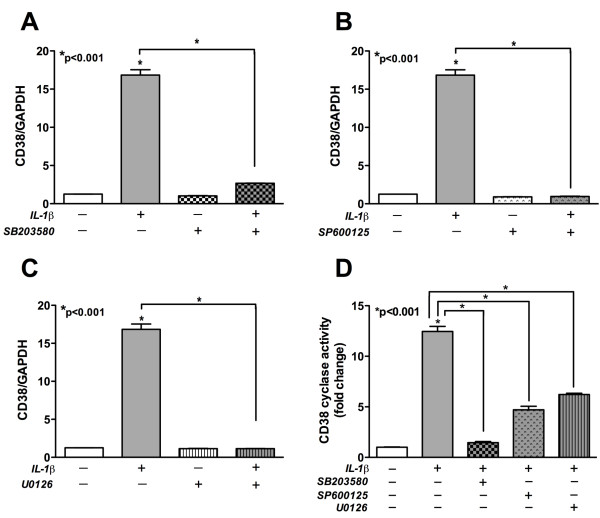
MAPKs regulated CD38 expression and function in IL-1β-activated astrocytes. Following 1 hour pre-treatment with various MAPK inhibitors, primary astrocytes were activated with IL-1β, 20 ng/ml. Untreated controls were maintained in parallel. CD38 mRNA levels were measured using real-time PCR while CD38 activity, as a measure of CD38 function, was analyzed using cADPR cyclase assay. As expected, IL-1β alone significantly increased CD38 expression and activity as compared to untreated controls (p < 0.001, all panels). Basal CD38 expression was unchanged (p > 0.05, A-C) by inhibitor pre-treatment. The IL-1β-induced increase in CD38 mRNA expression was abrogated by pre-treatment with inhibitors specific to (A) p38, SB203580 (p < 0.001) (B) JNK, SP600125 (p < 0.001) and (C) ERK, U0126 (p < 0.001). (D) Pre-treatment with each of the MAPK inhibitors significantly inhibited the IL-1β-mediated CD38 cADPR cyclase activity in astrocytes (p < 0.001).